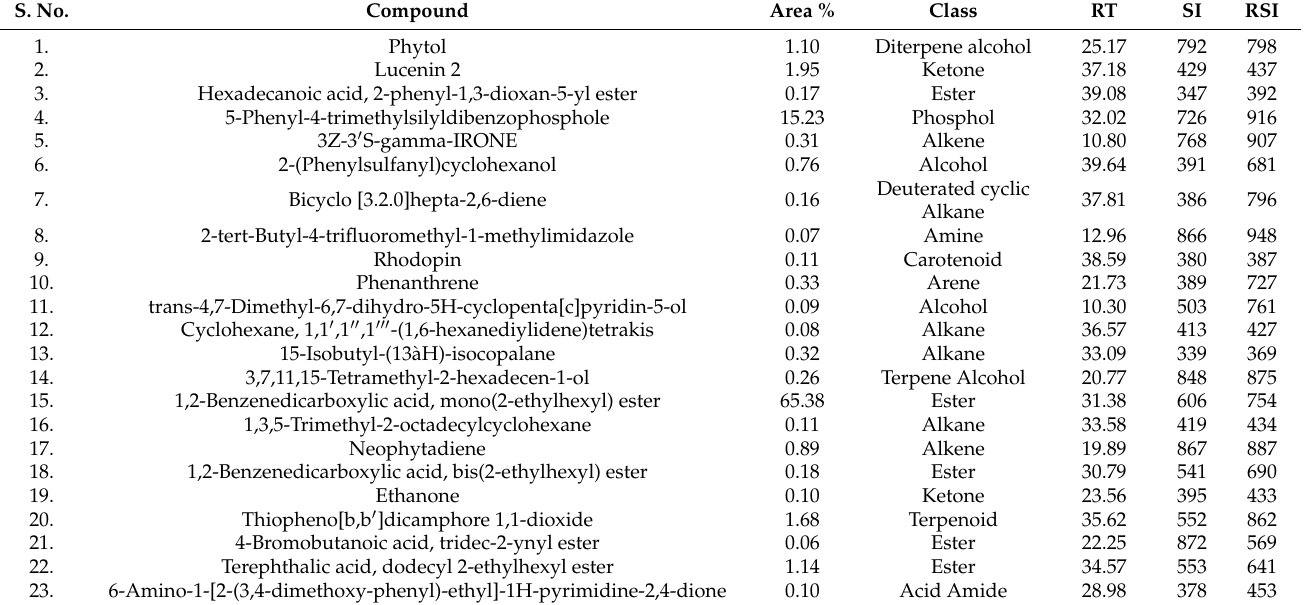
Figure 7. GC–MS graph presenting retention time and m/z ration ( A ) leaves retention time and ( C ) fruits retention time, ( B ) leaves m/z ration and ( D ) fruit m/z ration. Table 1. GC–MS analysis of A. nitida leaves crude extract.